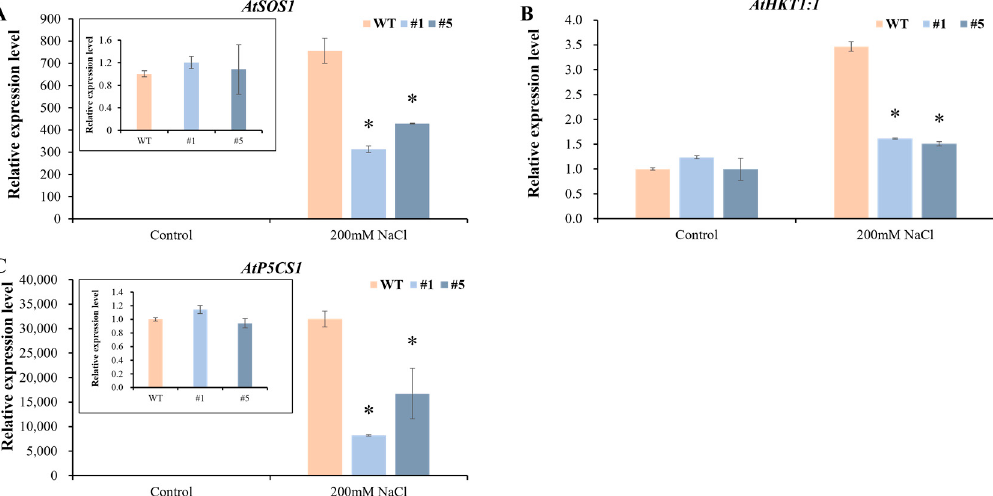
Figure 9. The expression level of salinity-related genes in CmHSP90.5 transgenic Arabidopsis and Col-0 plants after salt treatment. The expression level of AtSOS1 (A) , AtHKT1:1 (B) , AtP5CS1 (C) was measured after salt treatment. The Arabidopsis AtActin2 gene was used as the reference gene. Error bars represent ± SE. * Statistically significant differences were compared with Col-0 plants under different conditions. Value of p < 0.05 was considered to be statistically significant.